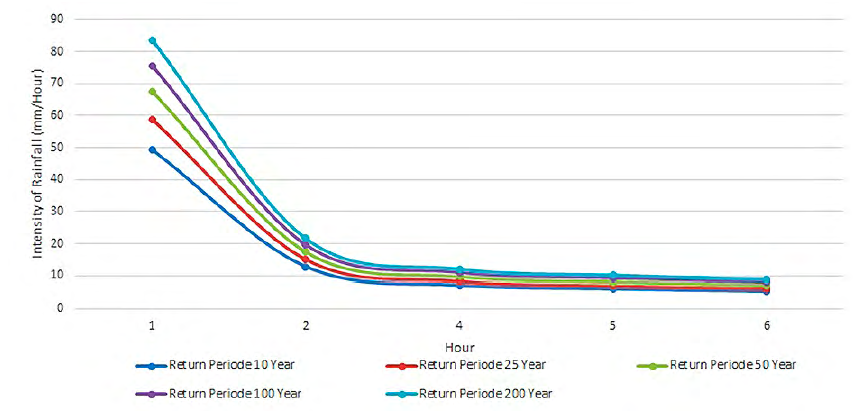
Figure 12. Intensity Duration Frequency in Pekalongan